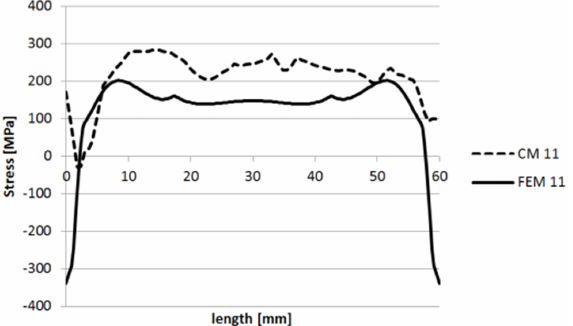
Figure 46. Stress levels in 11 direction along the AB line